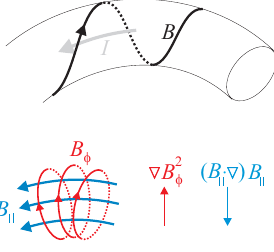
Fig. 2. A curved flux-rope carrying current I . At the bottom panel the poloidal ( B φ ) and axial ( B k ) magnetic field components are sketched: the gradient of the poloidal field pressure is directed up- ward, and the tension of the axial component acts